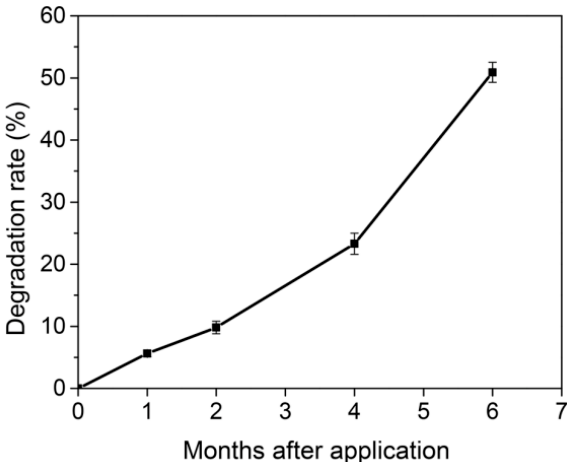
Figure 7. Degradation rate of MOF.